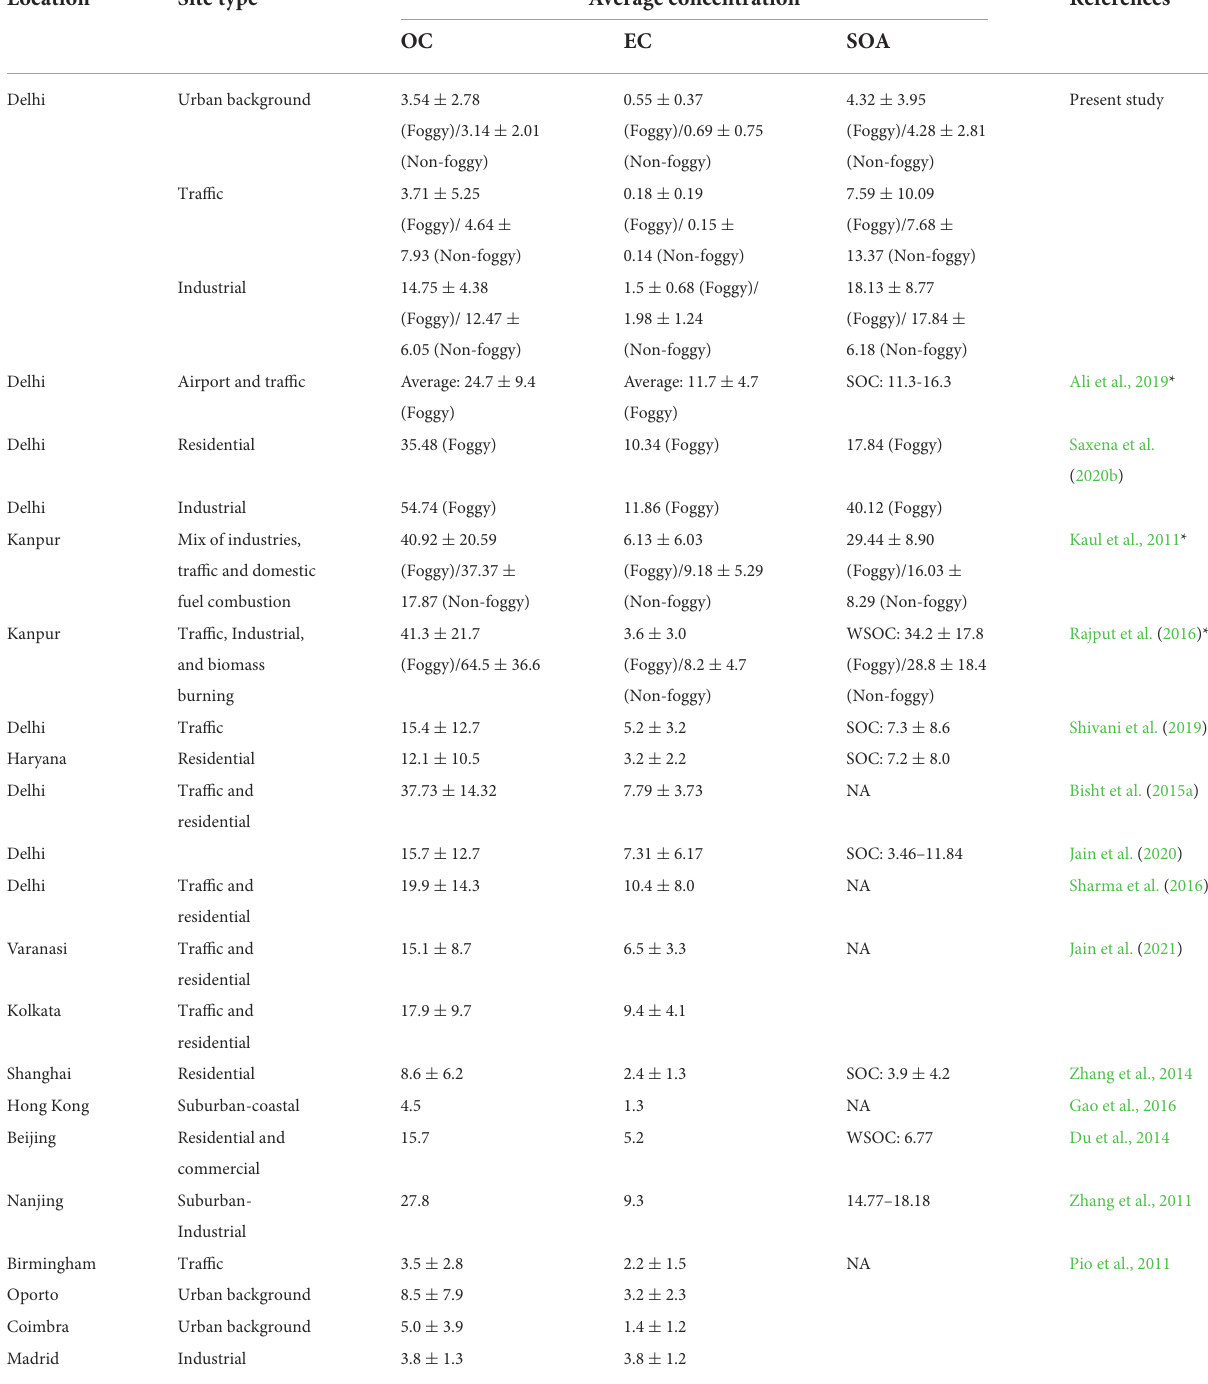
TABLE 2 Statistics for carbonaceous aerosol mass concentrations in PM 2.5 measured in the major cities of India and the world ( µ g/m 3 ).